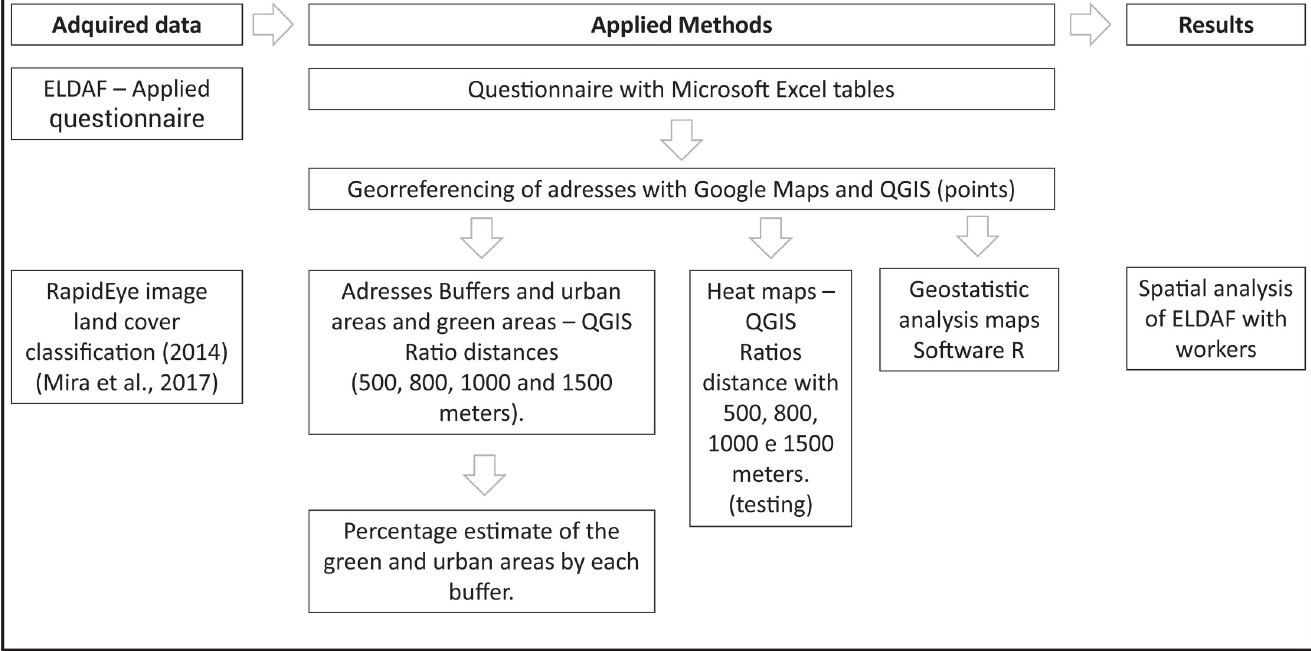
Fig 1. Methodological description of the georeferencing process.